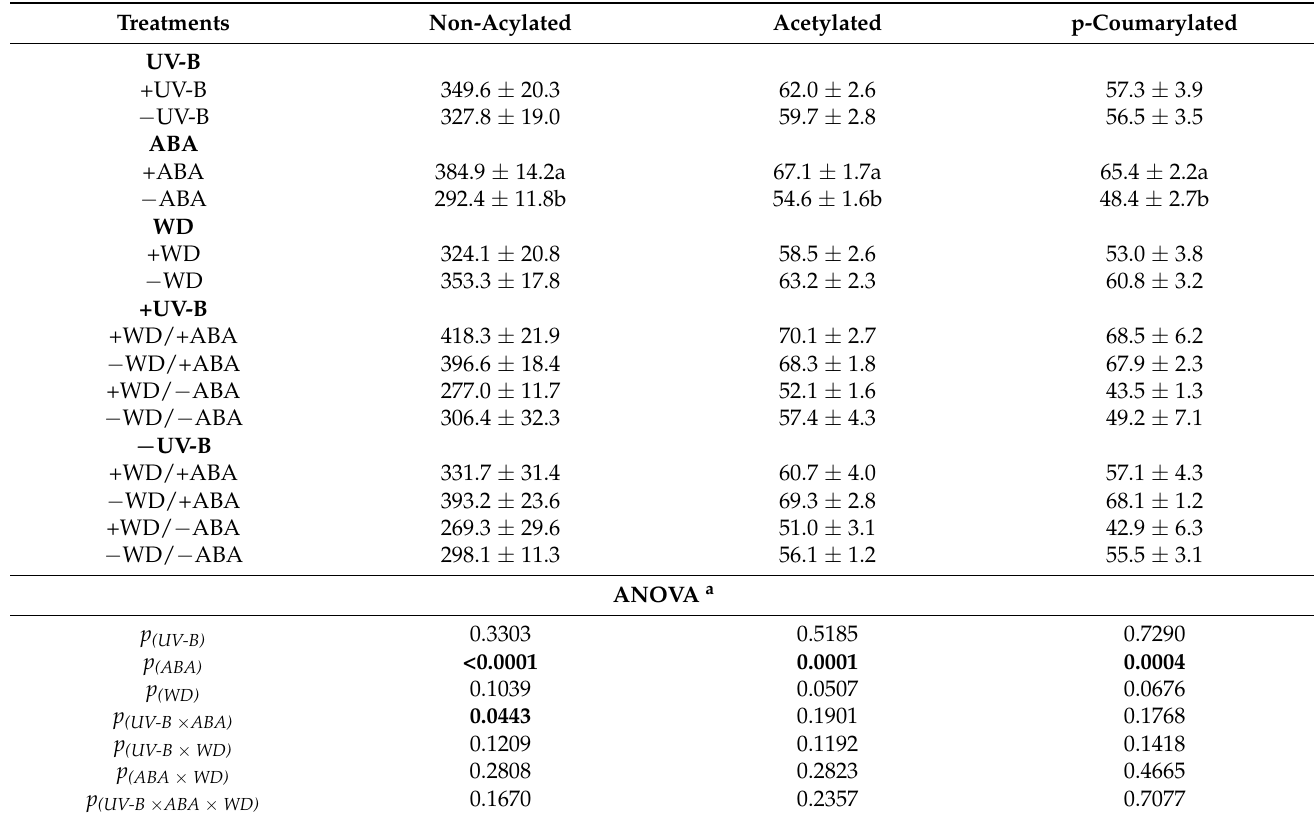
Table 3. Anthocyanins (grouped by acylation; mg L − 1 ) determined in wines from Malbec plants exposed to combined UV-B, WD and ABA